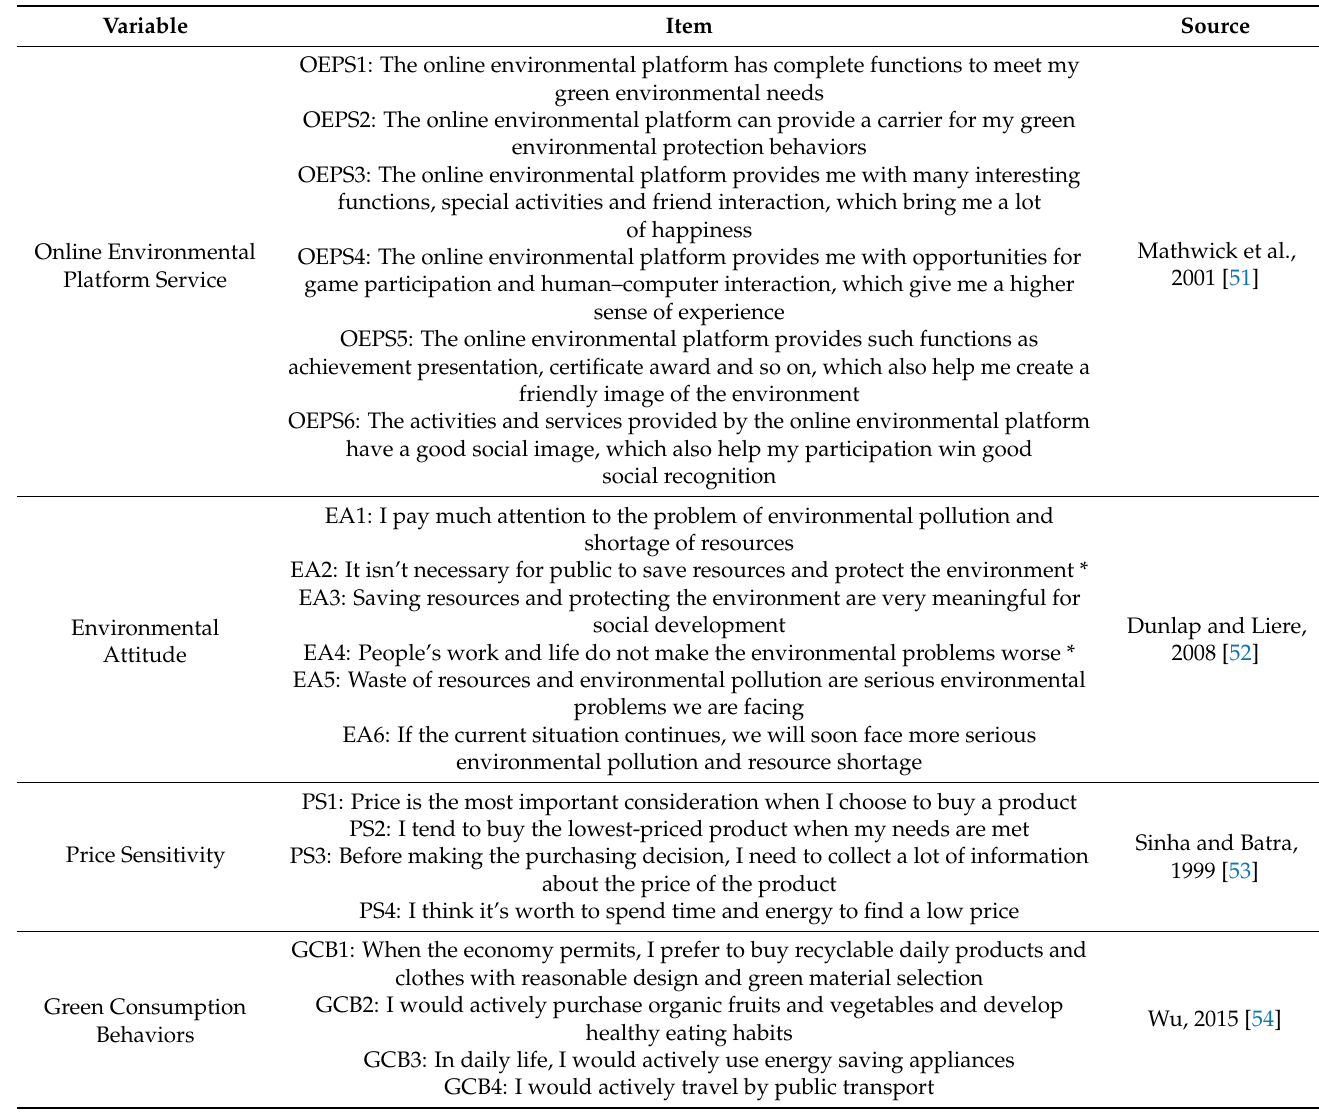
Table A2. The specific items of all